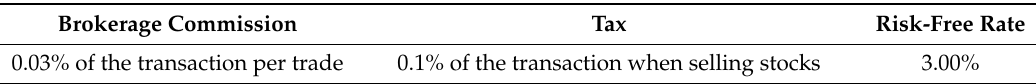
Table 3. Transaction costs and risk-free rate.